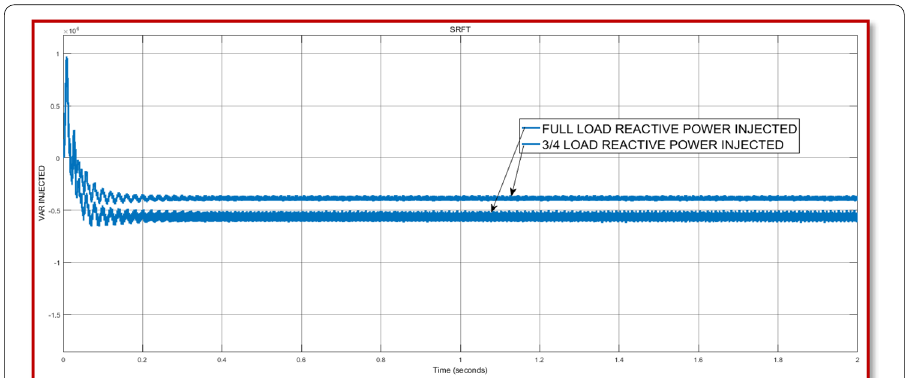
Fig. 16 Reactive power injections at PCC for 3/4 Th and full load conditions